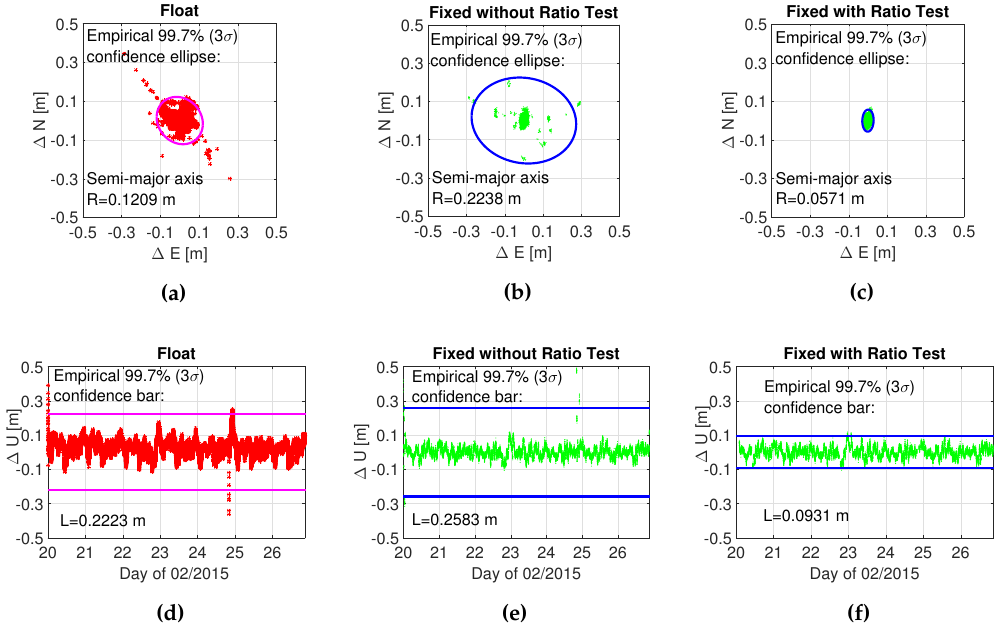
Figure 8. The positioning errors and the 3 σ confidence circle (bar) in the horizontal and vertical directions. The left, middle and right panels show float, ILS fixed and ILS fixed with ratio test solutions. The horizontal axis in the lower panels represent the day of 02/2015. ( a ) Float N-E; ( b ) Fixed N-E without the ratio test; ( c ) Fixed N-E with the ratio test; ( d ) Float U-T; ( e ) Fixed U-T without the ratio test; ( f ) Fixed U-T with the ratio